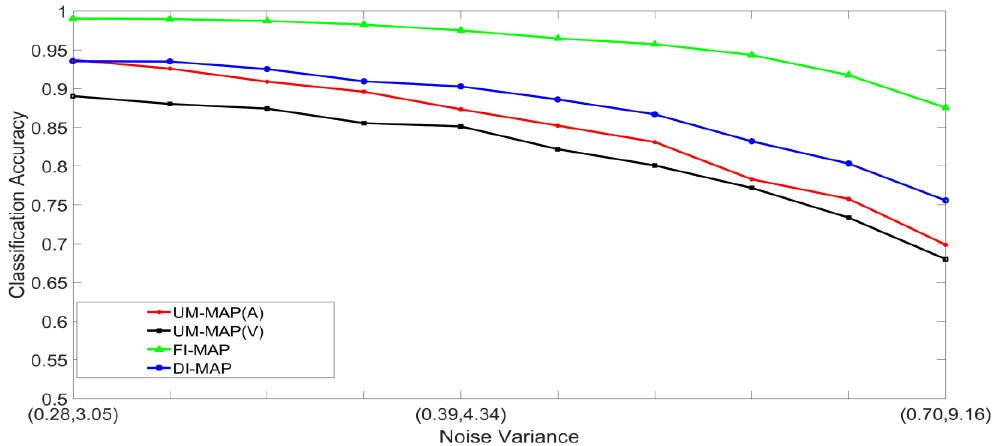
Figure 12. Classification accuracy, as a function of noise, and α = 0.8 in both stimuli, for the MAP-based classification systems.